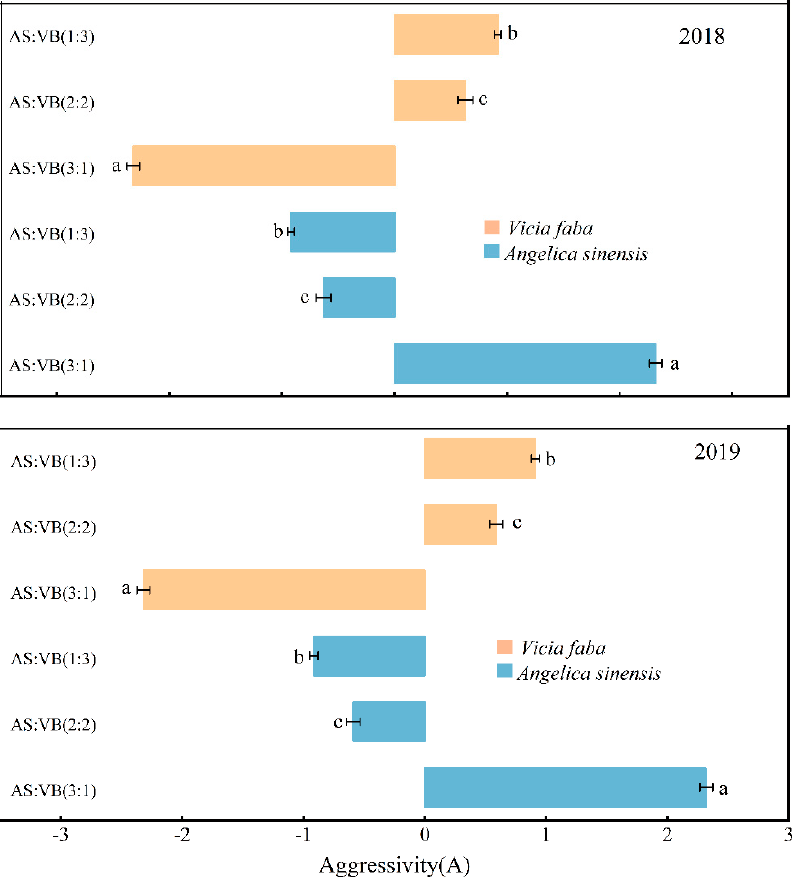
Figure 2. Land equivalent ratios (LERs) of the A. sinensis / V. faba intercropping patterns in 2018 and in 2019. Bars bearing different letters within the same LER indicate significance at p < 0.05. Error bars epitomize the standard deviation of the means. The dashed lines denote an LER equal to 1. AS/VF (3:1), three rows of A. sinensis + one row V. faba ; AS/VF (2:2), two rows of A. sinensis + two